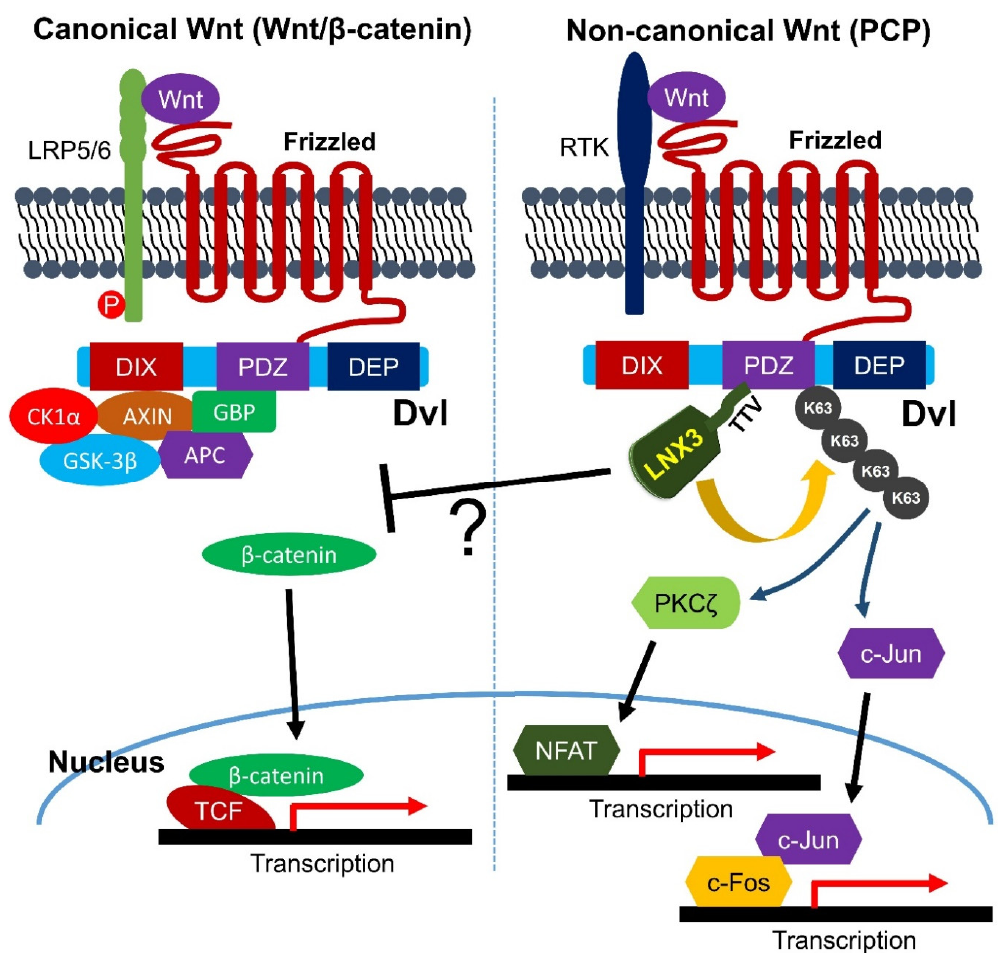
Figure 3. Schematic drawing of differential regulation of canonical and non-canonical Wnt signaling by LNX3. By canonical Wnt stimuli via LRP5/6 and Frizzled receptors, the Dvl recruits the β -catenin destruction complex to the plasma membrane including CK1 α and GSK-3 β kinases responsible for the β -catenin phosphorylation. As a consequence, the stabilized non-phospho (active) β -catenin is translocated to the nucleus where it binds to and stimulates TCF transcription factors. In noncanonical Wnt signaling, when Wnt ligand binds to Frizzled and RTK receptors, Dvl together with Frizzled undergoes endocytosis to trigger a signaling cascade that drives PKC and c-Jun activation. While PKC activates NFAT transcription factor, c-Jun in conjunction with c-Fos forms AP-1 transcription complex. The C-terminal PDZ-binding motif of LNX3 ended with TTV may directly bind to PDZ domain of Dvl, and then induce K63 linked polyubiquitylation into the Dvl, which is a prerequisite event for the subsequent endocytosis of Frizzled/Dvl complex. Though LNX3 may interfere with canonical Wnt signaling, the detailed mechanism has not been clearly validated yet. PCP; planar cell polarity, Wnt; Wingless and Int-1, LRP5/6; Low density lipoprotein receptor-related protein 5 and 6, Dvl; Dishevelled, RTK; receptor tyrosine kinase, DIX; Dishevelled homologous domain, PDZ; PSD95 / DLGA / Zo-1, DEP; Dishevelled / Egl-10 / Pleckstrin, GSK-3; Glycogen Synthase Kinase-3, GBP; GSK-3 binding protein, CK1; Casein kinase 1, APC; Adenomatous Polyposis Coli, TCF; T-cell factor, PKC; Protein kinase C, NFAT; Nuclear factor of activated